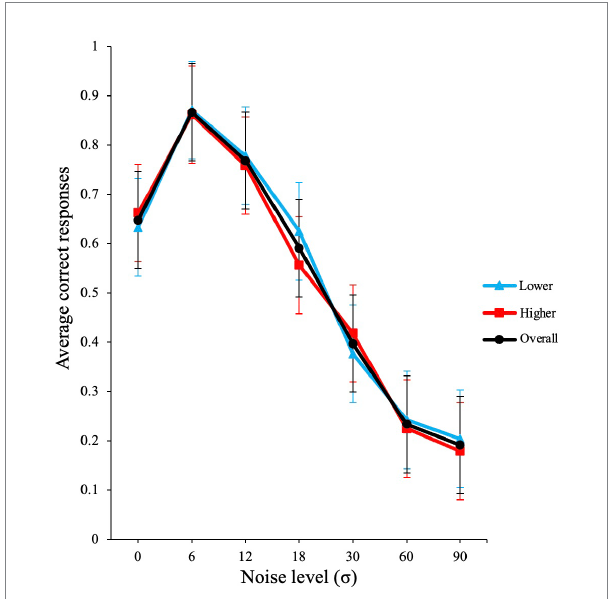
FIGURE 2 Inverted u-shaped function (SR effect) from Experiment 1. The graph illustrates the raw average proportion correct versus σ noise level. Error bars show standard errors of the means over participants. The blue line illustrates lower AQ participants, and red line shows higher AQ participants.